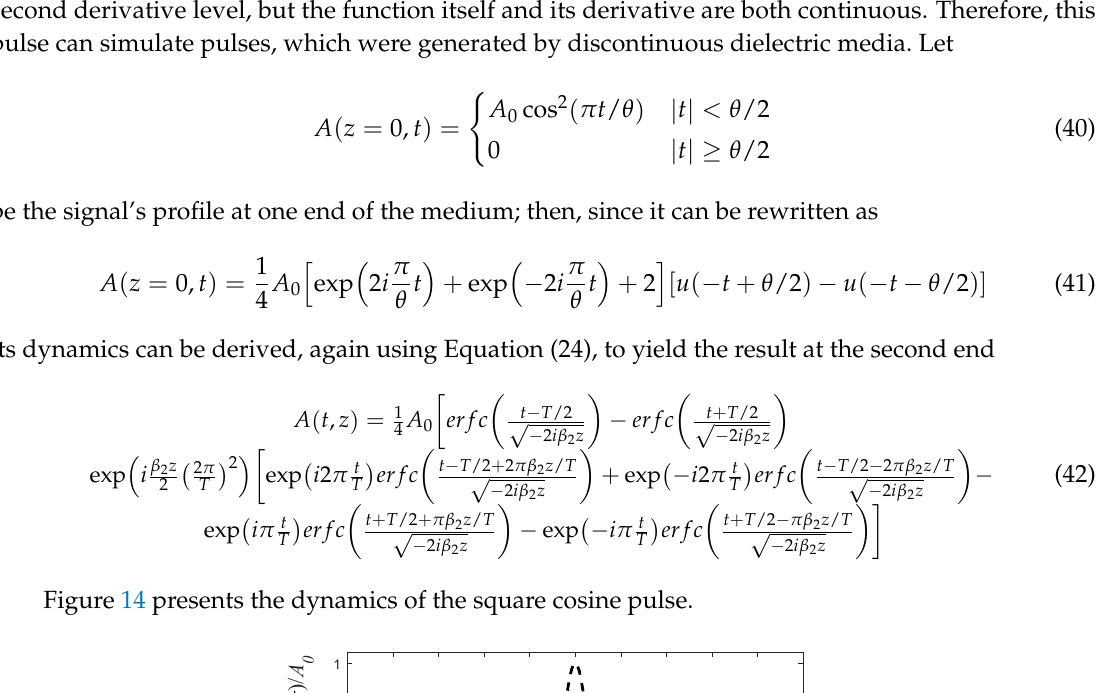
Figure 13. Same as Figure 2, but for the intensity (